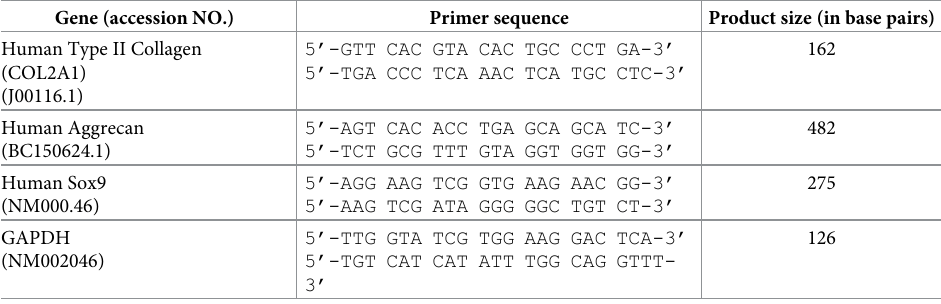
Table 1. Primers used for RT-PCR analysis of chondrocyte